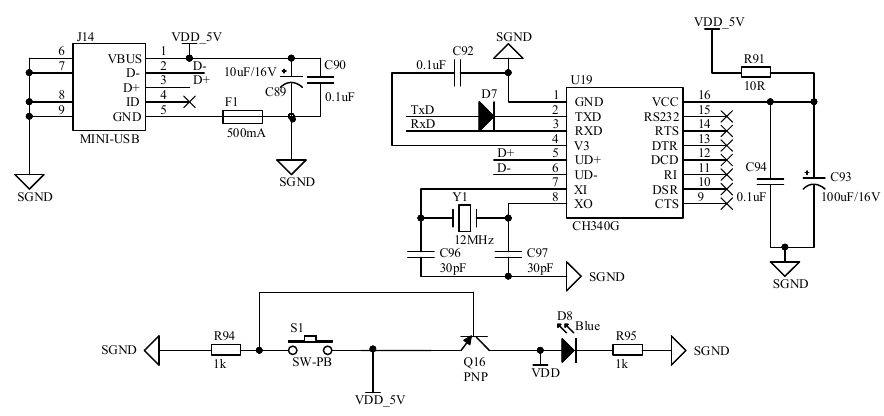
Figure 4. Serial communication and ISP circuit.